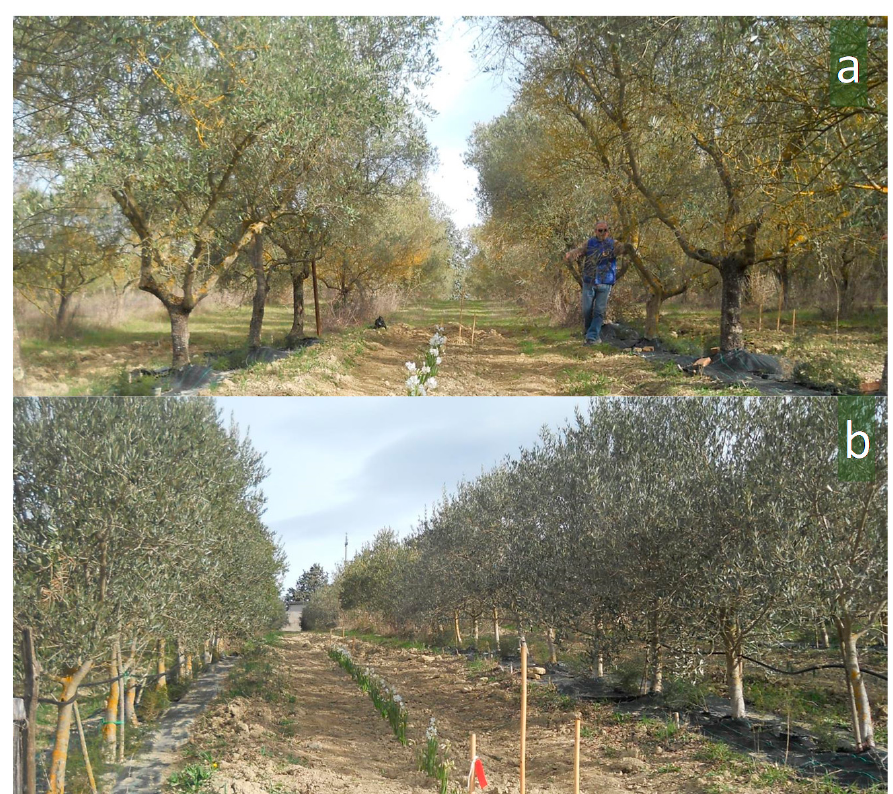
Figure 1. Top: Schematic representation of the two orchard systems studied: a high-density (HD) and a super high-density (SHD) system. Tree age and spacing and canopy height are representative of typical, mature, HD and SHD system, respectively. Bottom: pictures of the HD ( a ) and SHD ( b ) orchards.